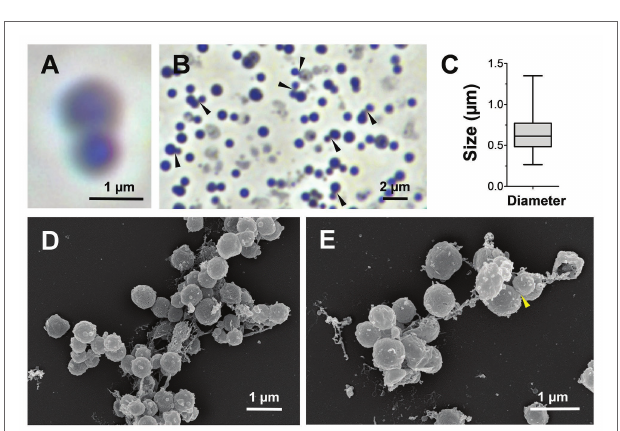
FIGURE 4 | Microscopy images and cell size plot of strain KS4 T . Phase contrast (A,B) and electron microscopic images (D,E) of strain KS4 T are shown. For determination of the cell size (C) , at least 100 representative cells were counted manually or by using a semi-automated object count tool. Cells, for which we observed budding as potential mode of cell division, are indicated by black or yellow arrows ( B and E ,